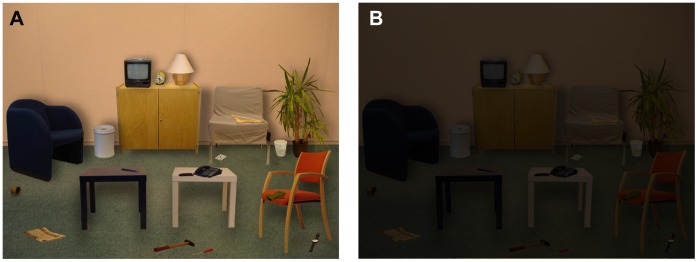
The constructed image of a living room used in the 2D Light Lab.The image contained 22 everyday objects that varied in size, colour and contrast. The objects were (from left to right and top to bottom): small television, alarm clock, table-lamp, armchair, trashcan, cupboard, bench, coat hanger, vase, plant, playing card, mug, dark table, pencil, white table, telephone, chair, pair of gloves, newspaper, hammer, screwdriver and watch. The left image (A) shows the image at full intensity, the right image (B) shows the image at a low intensity.